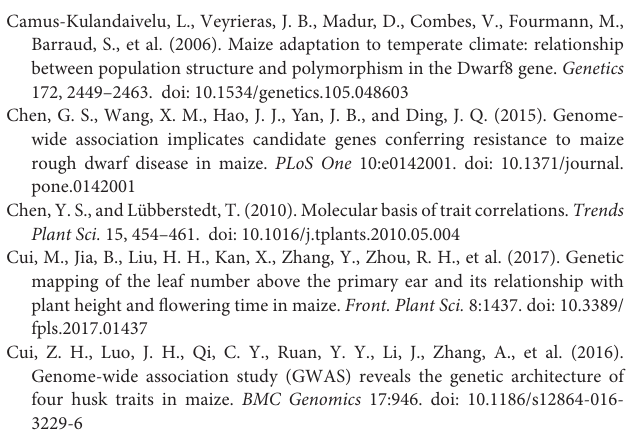
Supplementary Figure 1 | Frequency distribution of the total aboveground dry matter and organ’s dry matter at the V3 and V6 stage. (A–C) represent the results at V3 stage and (D–G) represent the results at V6 stage. Supplementary Figure 2 | Frequency distribution of the organ’s dry matter partition coefficient at the V3 and V6 stage. (A,B) represent the results at V3 stage and (C–E) represent the results at V6 stage. Supplementary Table 1 | Gene annotation of GWAS significant